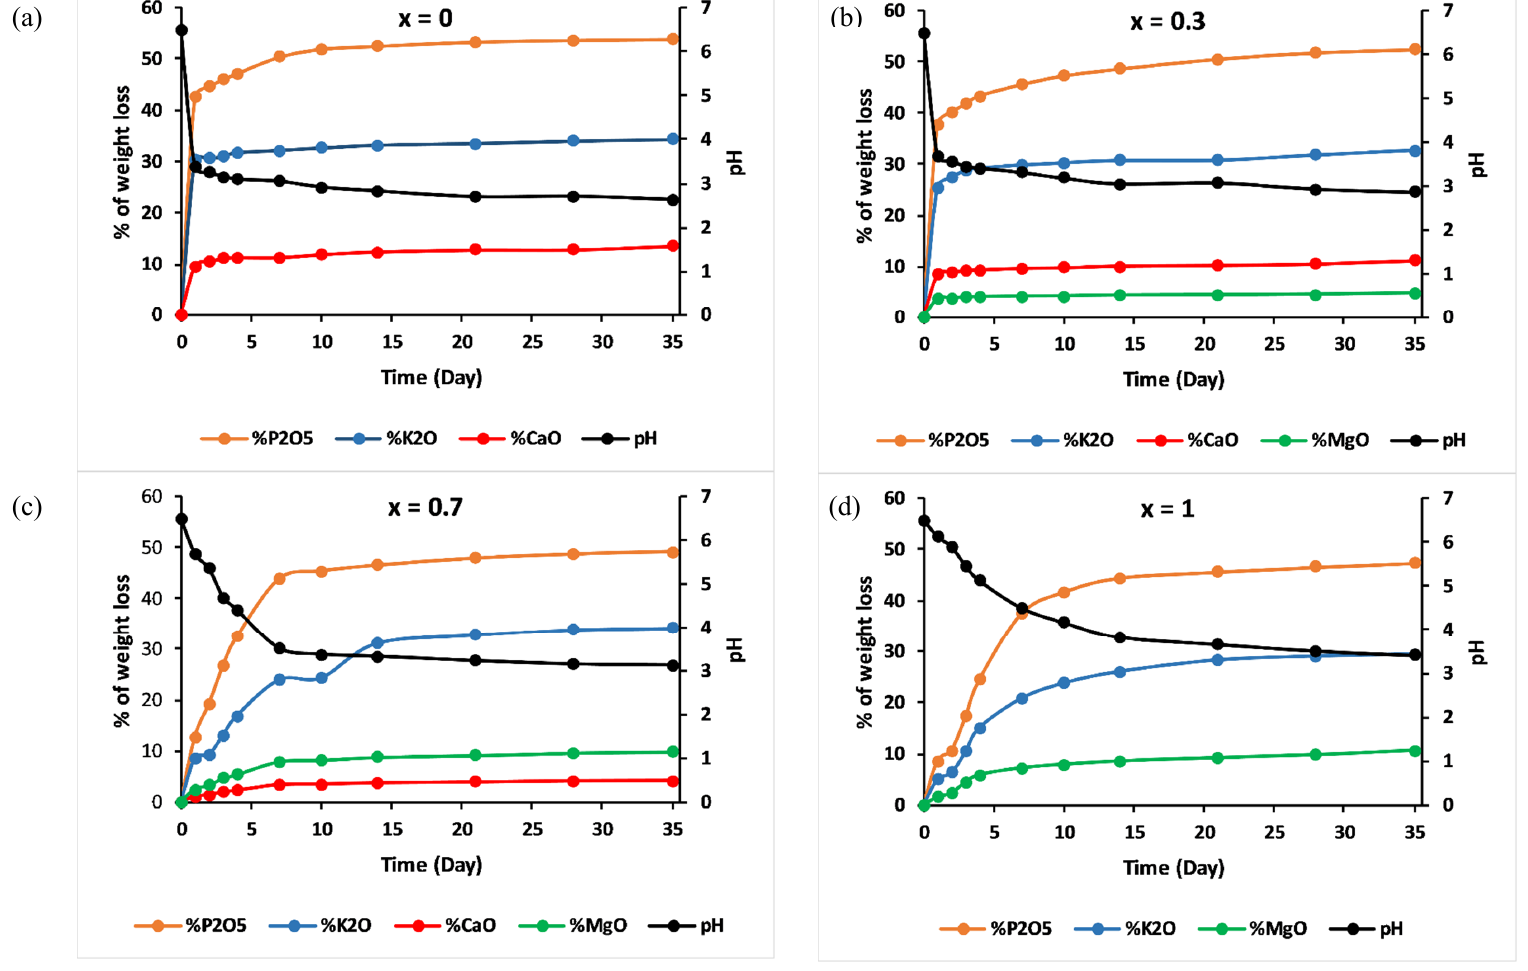
Figure 9. % of glass constituents analysed in the leachate solutions (cations in form of oxides) normalized to the initial glass weight and pH measurements versus time for ( a ) x = 0, ( b ) x = 0.3, ( c ) x = 0.7 and ( d ) x =